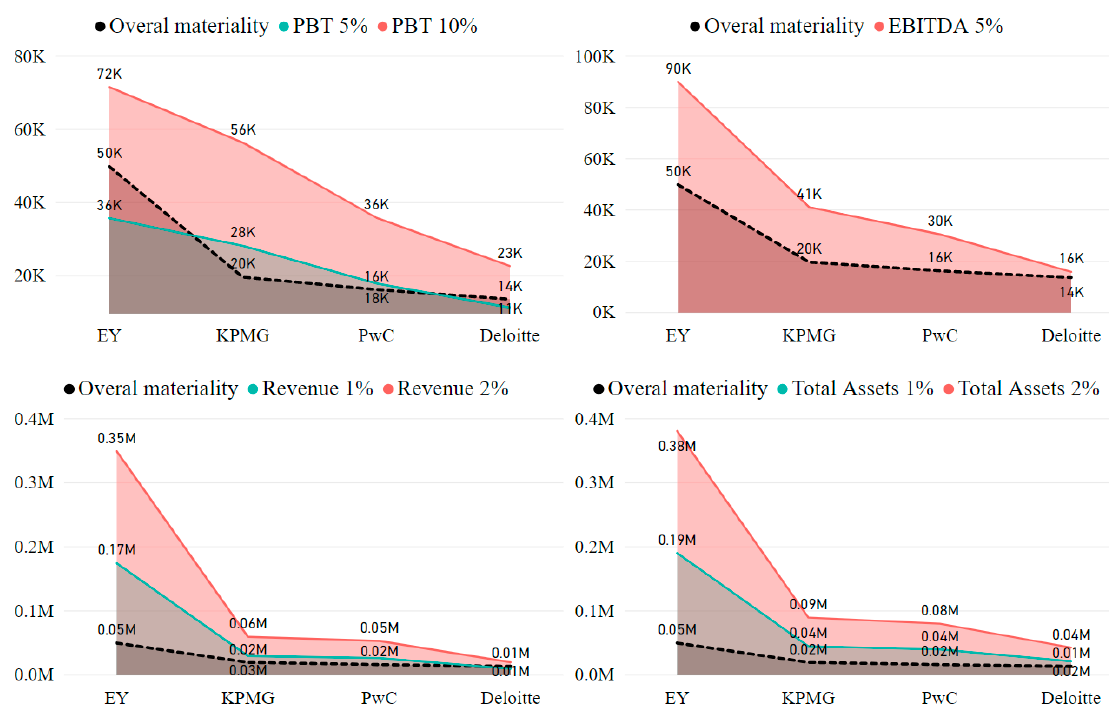
Figure 12. Overall materiality used by Big 4 auditors in relation to the percentage mentioned in ISA 320 and literature. Source: own elaboration based on analyzed data.